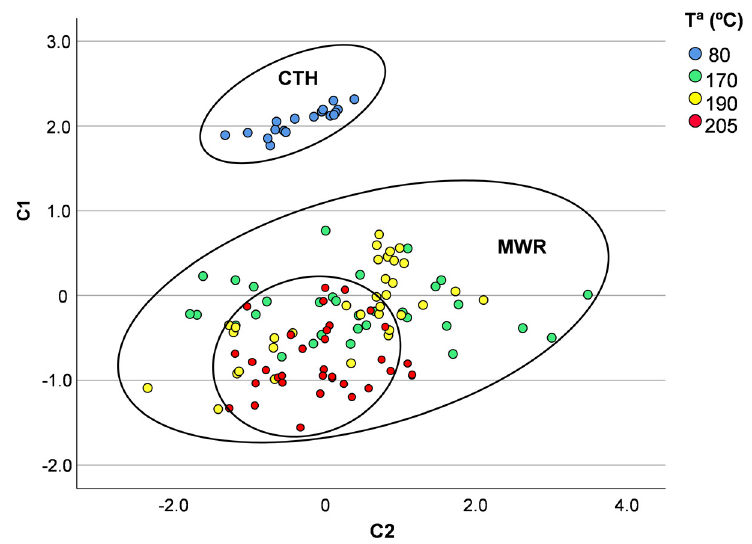
Figure 12. PCA of UV − Vis spectra data obtained (235–450 cm − 1 ). Again, the experiments are grouped into two main clusters. A homogeneous cluster corresponding to the 80 ◦ C series and a heterogeneous cluster with the rest of the series. In this analysis, the samples corresponding to the 205 ◦ C series tend to appear together within the heterogeneous cluster. Ellipses mark these groupings.